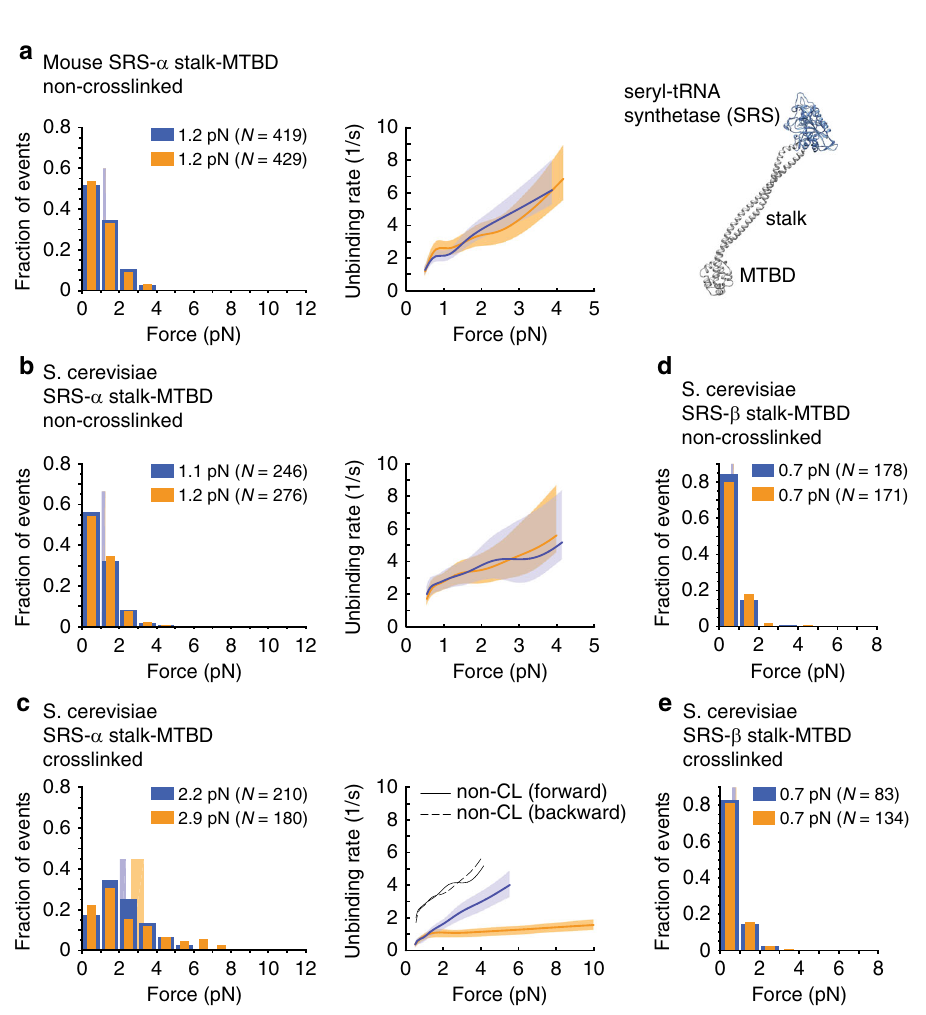
Fig. 4 Unbinding-force behaviors of the SRS-stalk-MTBD constructs. a , left: Normalized histograms of primary forward and backward unbinding forces for the SRS construct with the mouse stalk helices (a.a. 3019 – 3309) fused in the non-cross-linked α -registry (SRS 85:82), with mean values noted (95% CIs [1.1, 1.3] and [1.1, 1.3] pN, estimated by bootstrapping 4,000 samples). a , middle: Unbinding rate vs. force derived from the data on the left. The shaded areas are 95% CIs for the mean rates, estimated by bootstrapping. a , right: Model of monomeric T. thermophilus seryl-tRNA synthetase (SRS) (based on PDB entry 3ERR) fused to the near-full-length stalk and MTBD of dynein in the β -registry of the stalk helices (generated by aligning PDB entry 3WUQ and 4RH7, see Supplementary Note 1). b As in ( a ) but for the SRS construct with the S. cerevisiae stalk helices (a.a. 3019 – 3309) fused in the non-cross-linked α - registry (95% CIs [1.0, 1.2] and [1.1, 1.2] pN). c As in ( b ) but with the stalk helices cross-linked (K3077C, A3250C) in the α -registration (95% CIs [2.0, 2.4] and [2.6, 3.3] pN). d As in ( b ) but for SRS fused to the S. cerevisiae stalk and MTBD in the weak MT-binding β -registry (SRS 89:82) (a.a. 3015 – 3309) (95% CIs [0.6, 0.7] and [0.6, 0.7] pN). e As in ( d ) but with the stalk helices cross-linked (I3076C, L3247C) in the β -registration (95% CIs [0.6, 0.7] and [0.7, 0.8] pN). Source data are provided as a Source Data fi le